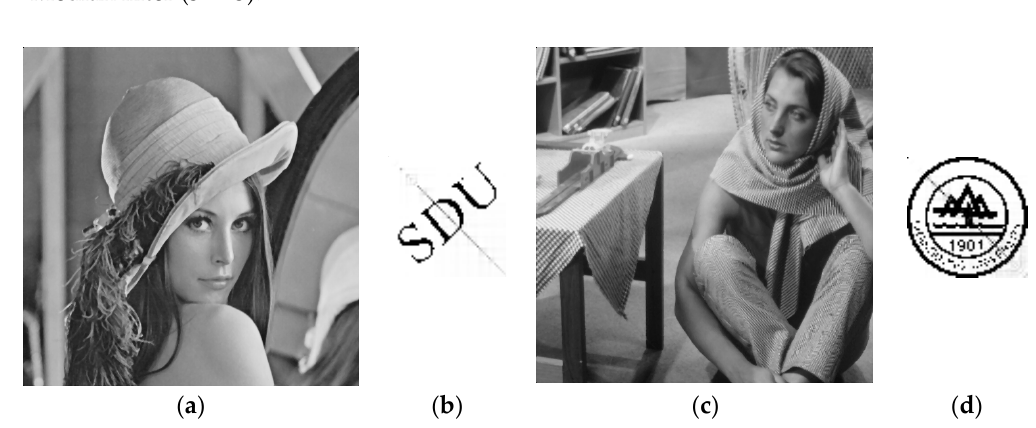
Figure 15. Watermarked images and extracted watermarks under median filter (3 × 3): ( a ) watermarked Lena; ( b ) extracted watermark w 1 ; ( c ) watermarked Barbara; ( d ) extracted watermark w 2 .